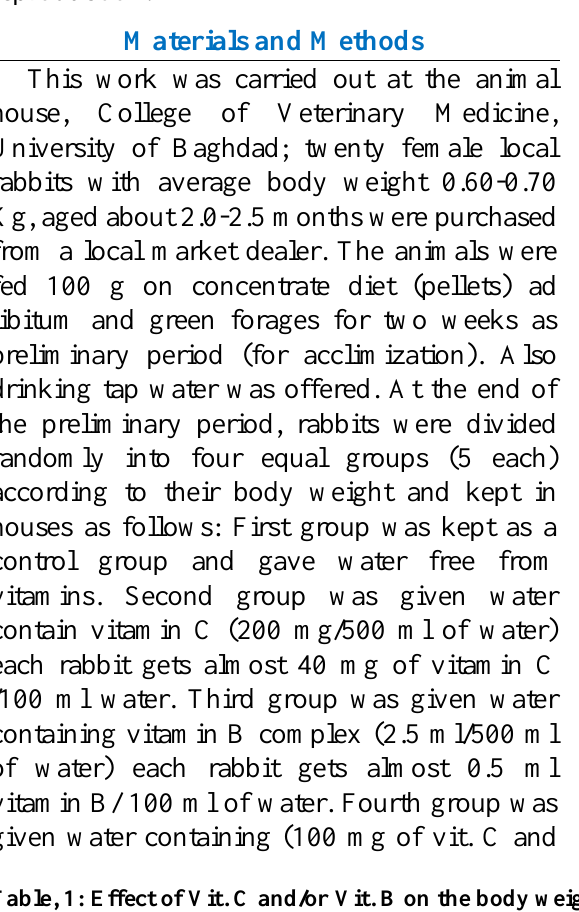
Table, 1: Effect of Vit. C and/or Vit. B on the body weight (g) of rabbits (Mean ± SE).